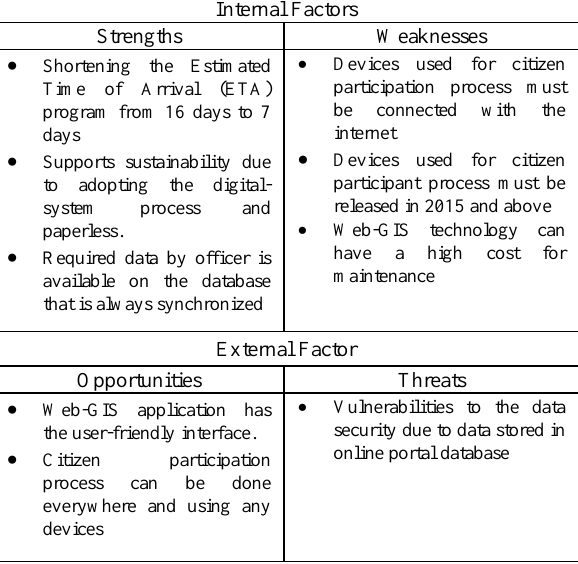
Table 4 . Details of qualitative descriptive observation